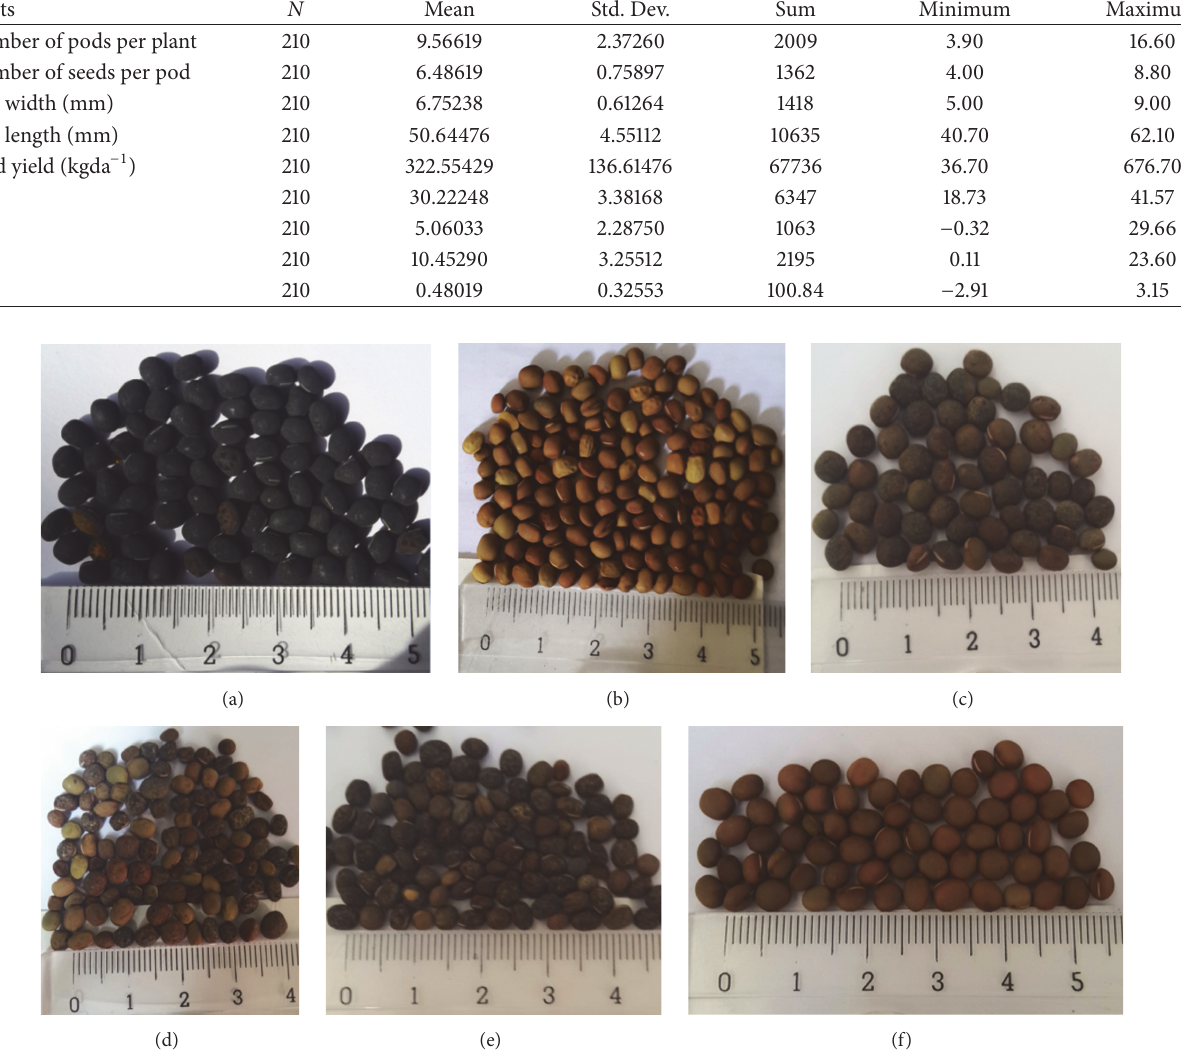
Figure 1: The appearance of the genotypes which distinctly differ from the others for seed coat colour. (a) Variety Karaelci, (b) variety Nilufer, (c) CU-2, (d) DV-1, (e) GB-6, and (f) GB-20.